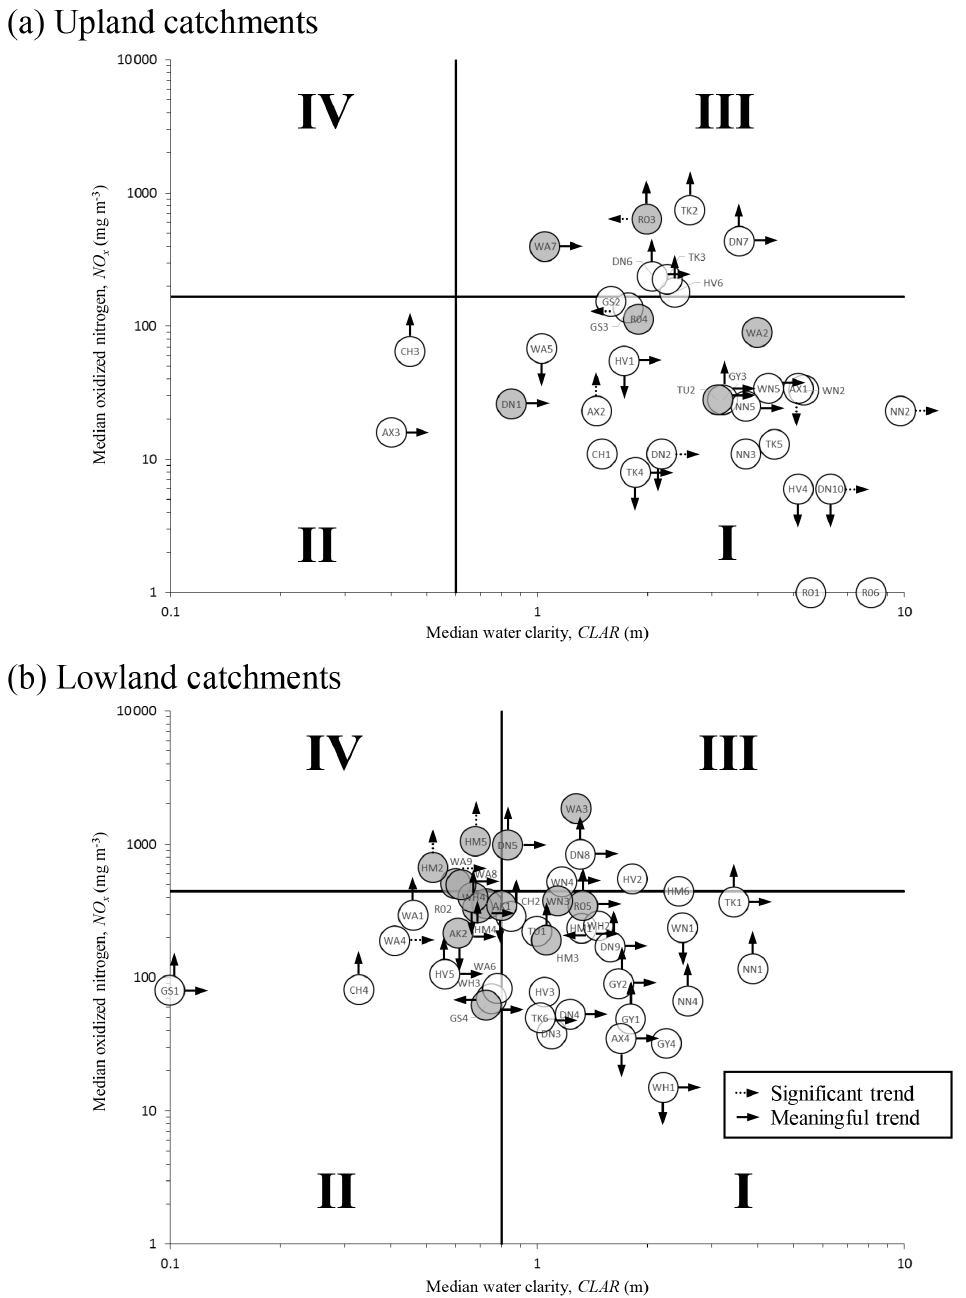
Figure 6. River water quality classes for upland (a) and lowland (b) catchments in New Zealand: (I) clean river with high visual water clarity (CLAR) and low dissolved inorganic nutrients (DIN); (II) sediment-impacted river with low CLAR and low DIN; (III) nutrient- impacted river with high CLAR and high DIN; and (IV) sediment- and nutrient-impacted river with low CLAR and high DIN. Classes are organized by ANZECC (2000) trigger values for water clarity ( x axis) and NO x ( y axis). Catchments that exceed ANZECC guidelines for DRP are indicated by gray-filled markers. Arrows indicate direction of trend over the 26 years inclusive from 1989 if significant (dashed) or meaningful (solid). No arrow means the trend was not